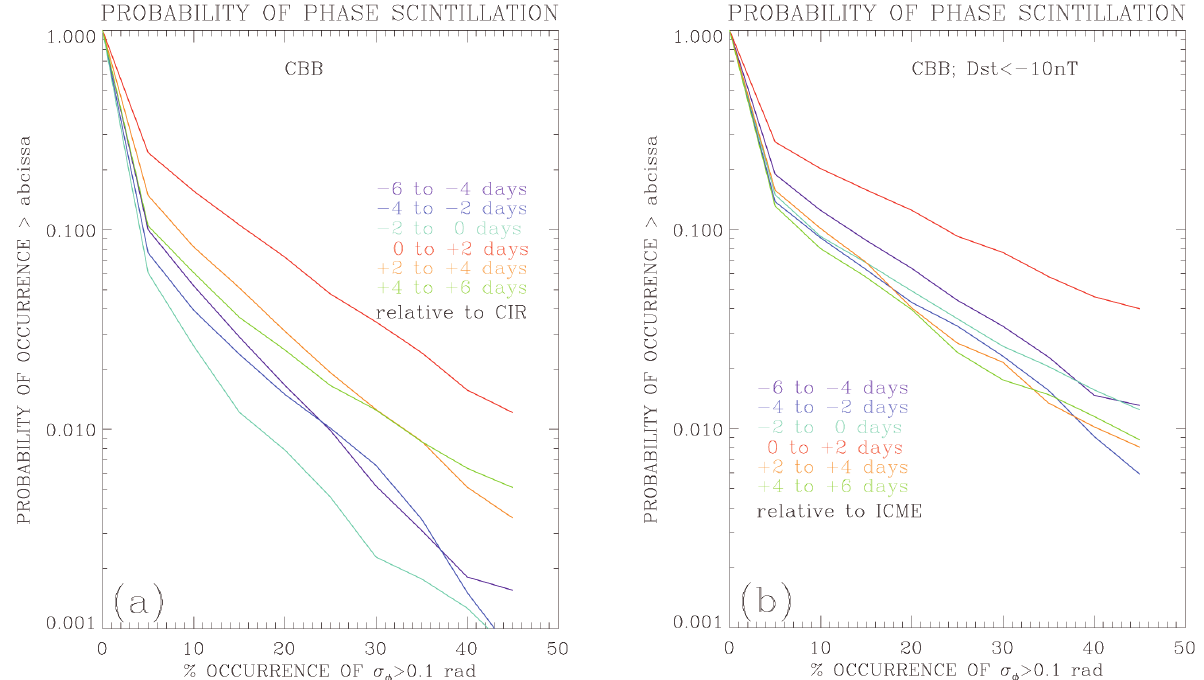
Figure 5. Cumulative probability distribution functions for the phase scintillation occurrence for Cambridge Bay, stepped by 2-day intervals before and after CIRs (n = 88) (a) and ICMEs ( Dst < −10 nT; n = 39)